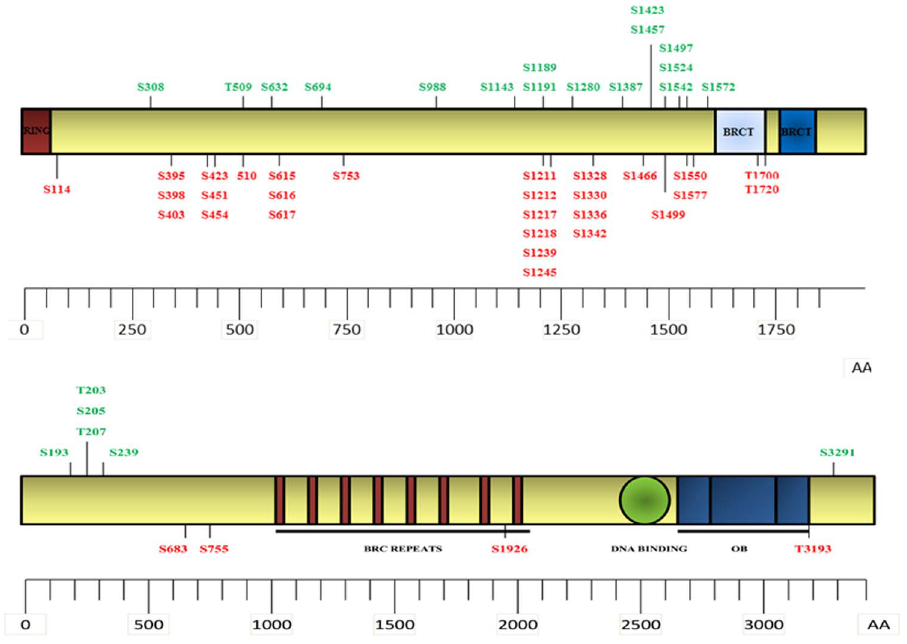
Figure 1. a. Summary of phosphorylation sites studied in BRCA1. Residues in green represent in vivo phosphorylation sites have been biologically characterized in the literature. Residues in red represent in vivo phosphorylation sites identified via throughput methods where biological functions have not yet been determined. b. Summary of phosphorylation sites studied in BRCA2. Residues in green represent in vivo phosphorylation sites that have been biologically characterized in the literature. Residues in red represent in vivo phosphorylation sites identified via throughput methods where biological functions have not yet been determined.